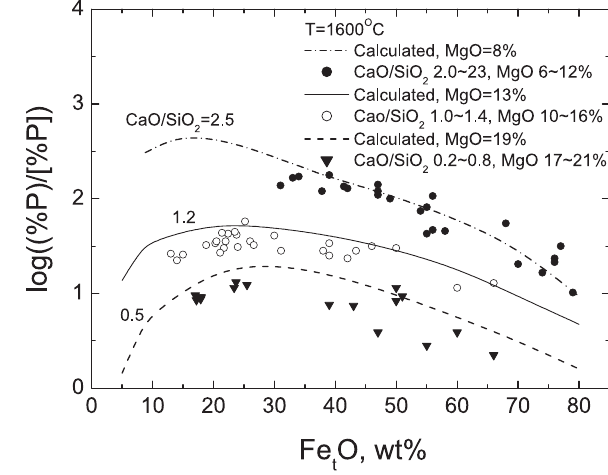
Fig. 8: The effect of FeO and slag basicity on the phosphorus distribution between the CaO-FetO-MgO-SiO